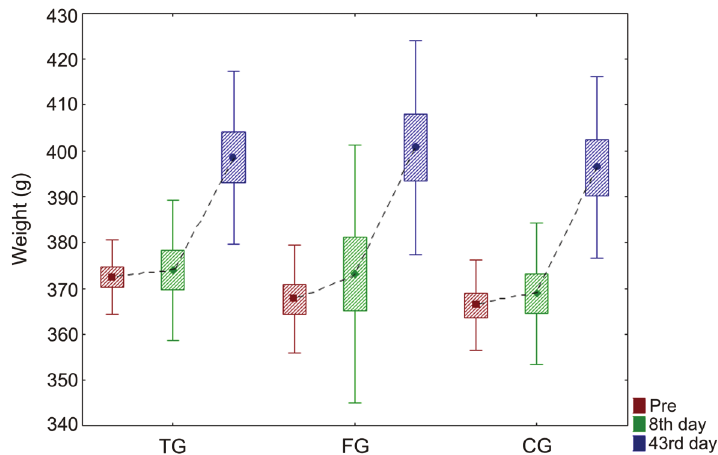
Figure 1. Comparison of weight within each group. Data are reported as averages, standard deviation and maximum and minimum errors. CG: control group; TG: transcutaneous electrical nerve stimulation (TENS) group; FG: functional electrical stimulation (FES) group. ANOVA was used for statistical analysis (P 4